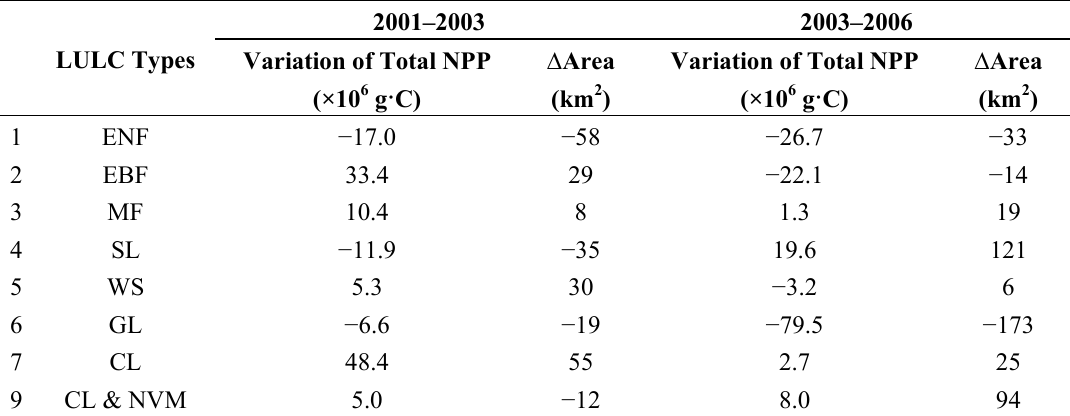
Table 3. Changes in LULC and NPP in Guangzhou from 2001 to